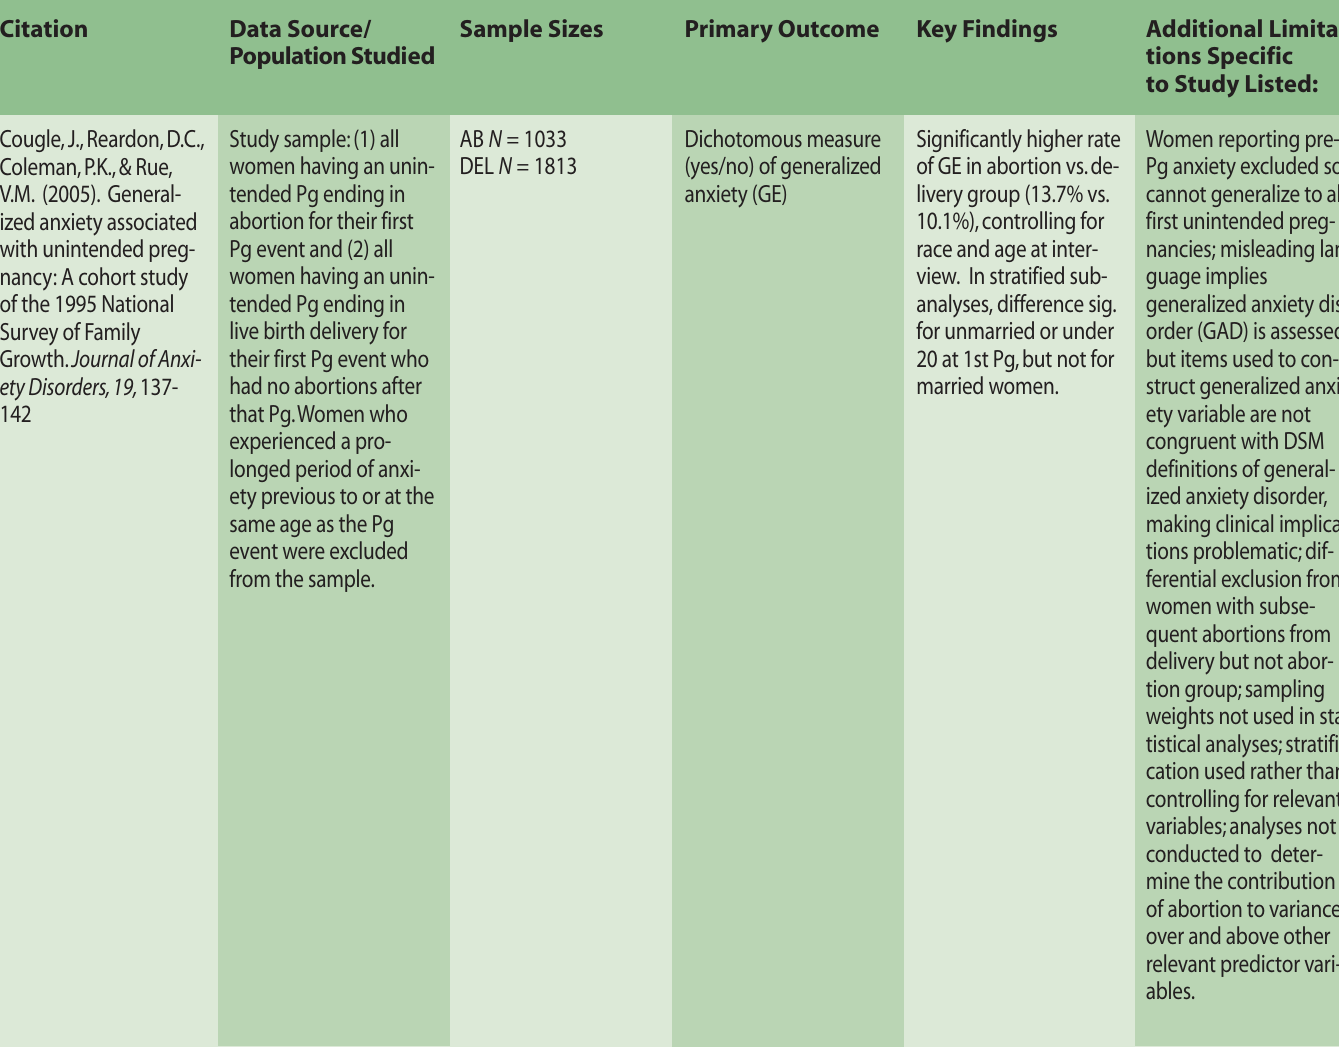
Table 1B: Secondary Analyses of Survey Data–Abortion vs.Comparison Groups U.S.STUDIES (continued) National Survey of Family Growth